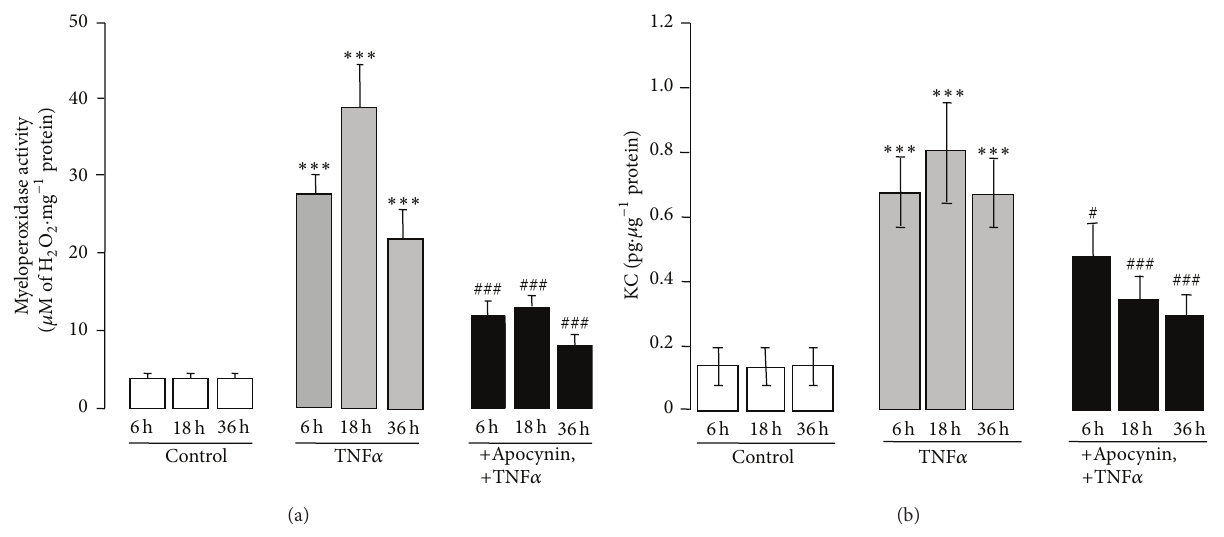
Figure 5: Apocynin decreases neutrophils infiltration and KC level in the colon of TNF 𝛼 -treated mice. (a) Neutrophils infiltration was determined by measuring MPO activity, as described in Section 2, in the colon of mice treated with TNF 𝛼 (10 𝜇 g ⋅ kg −1 , ip) in the presence or absence of apocynin (25mg ⋅ kg −1 , ip). Data are expressed as means ± S.E.M from 𝑛 = 5 mice in each group. ∗ 𝑃 < 0.05 , ∗∗ 𝑃 < 0.01 , and ∗∗∗ 𝑃 < 0.001 versus control; # 𝑃 < 0.05 , ## 𝑃 < 0.01 , and ### 𝑃 < 0.001 versus TNF 𝛼 ; (b) KC level was measured by ELISA in the colon of mice treated with TNF 𝛼 (10 𝜇 g ⋅ kg −1 , ip) in the presence or absence of apocynin (25 mg ⋅ kg −1 , ip) as described in Section 2. Data are expressed as means ± S.E.M from 𝑛 = 5 mice in each group. ∗ 𝑃 < 0.05 , ∗∗ 𝑃 < 0.01 , and ∗∗∗ 𝑃 < 0.001 versus control; # 𝑃 < 0.05 , ## 𝑃 < 0.01 , and ### 𝑃 < 0.001 versus TNF 𝛼